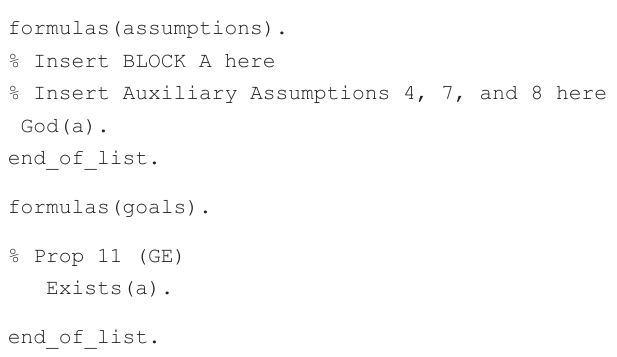
Figure 9: A prover9 script using the DAPI and Auxiliary Assumptions 4, 7, and 8 that implies